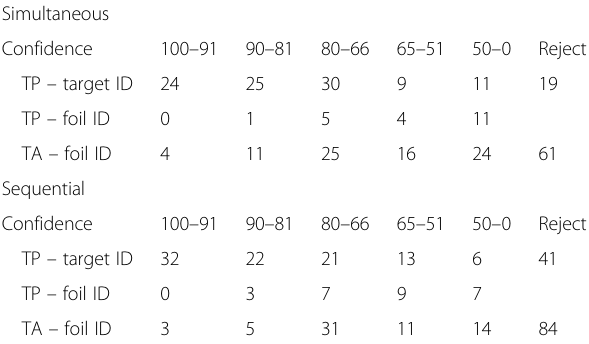
Table 4 Decision outcomes frequencies for simultaneous and